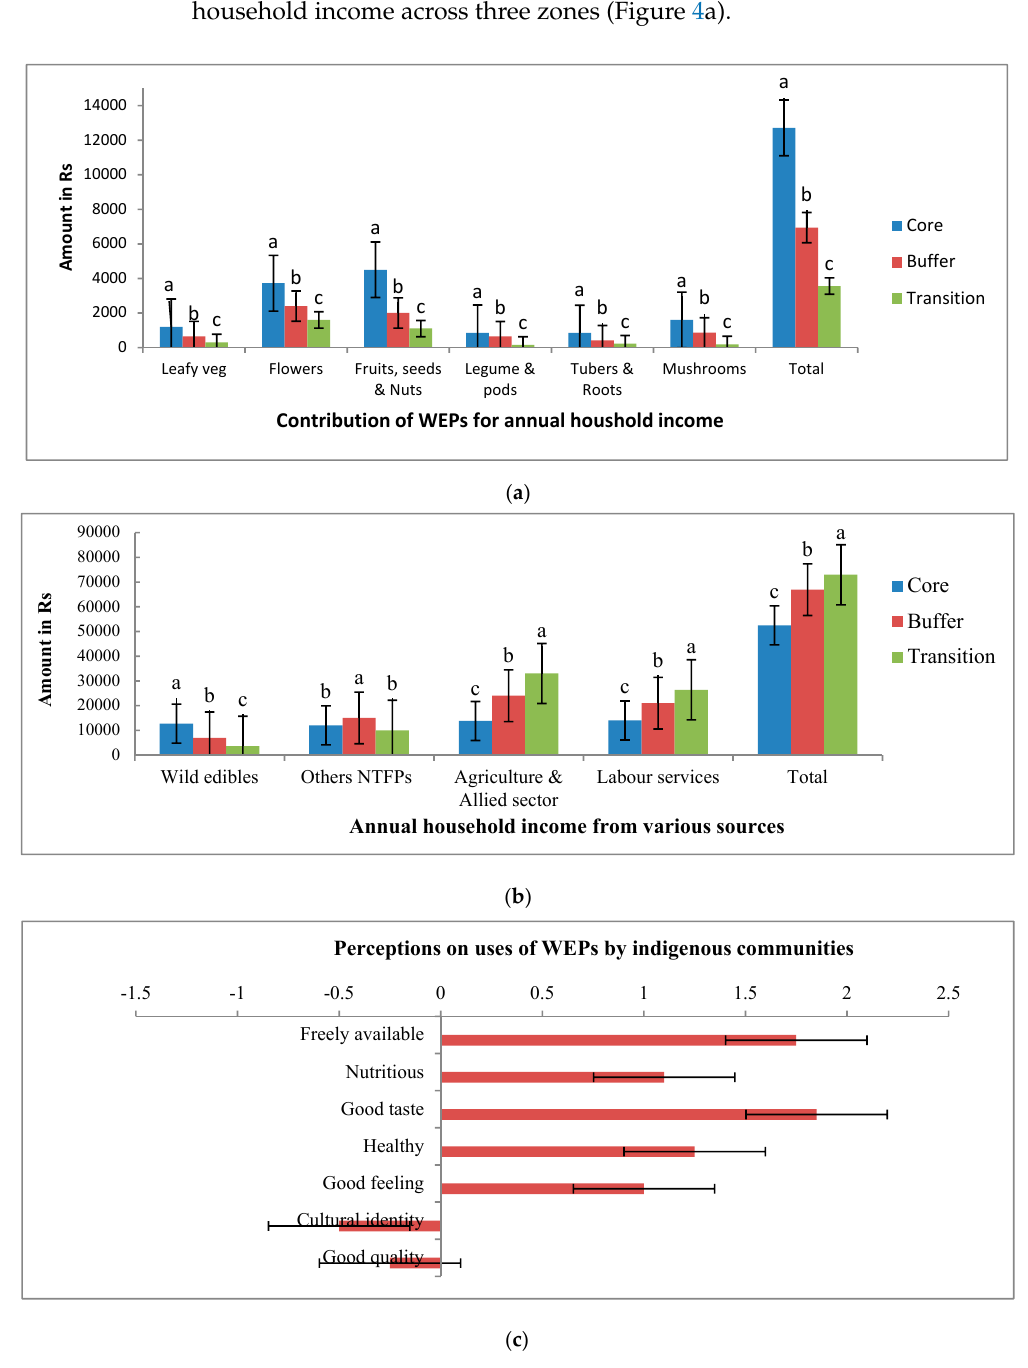
Figure 4. ( a ): Contribution of WEPs for household income of indigenous communities of AABR, Central India, Different letters denoted on bars for each category of WEPs are statistically different at p ≤ 0.05 (Note: Indian Rs 73/- equals to 1 US D) (N = 332 ±SEm of amount in Indian Rs). ( b ): Household income from major sources of indigenous communities of AABR, Central India, Different letters denoted on bars for each category of WEPs are statistically different at p ≤ 0.05 (Note: Indian Rs 73/- equals to 1 US D) (N = 332; ±SEm of amount in Indian Rs). ( c ): Perceptions on use of WEPs indigenous communities of AABR, Central India on a 5 point Likert scale (N = 332; ±SEm of scores).